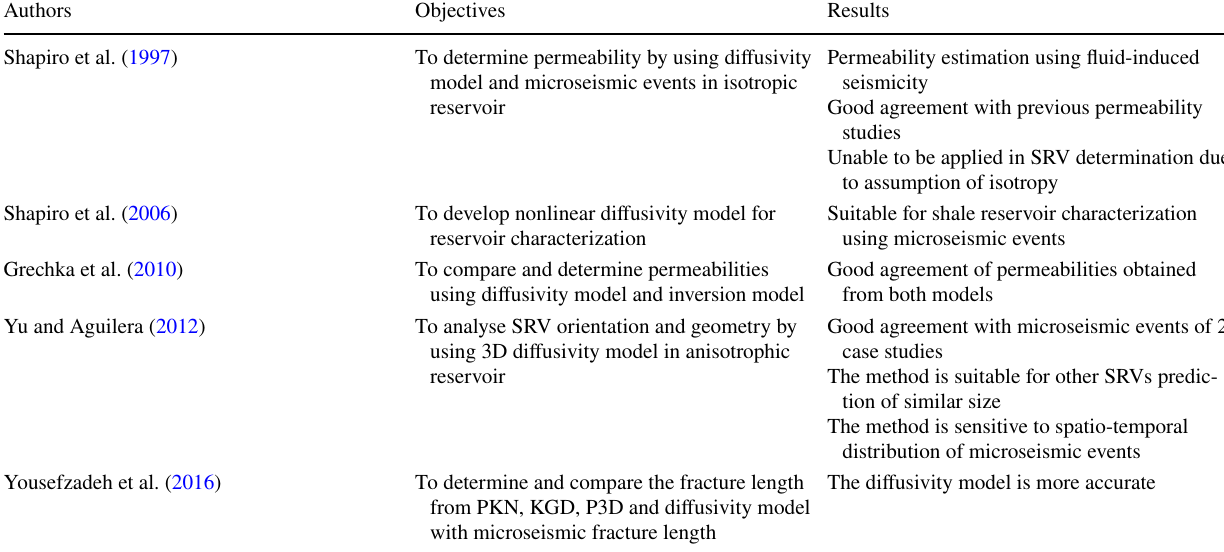
Table 2 Summary of researches conducted on studying analytical models (Grechka et al. 2010; Shapiro et al. 1997, 2006; Yousefzadeh et